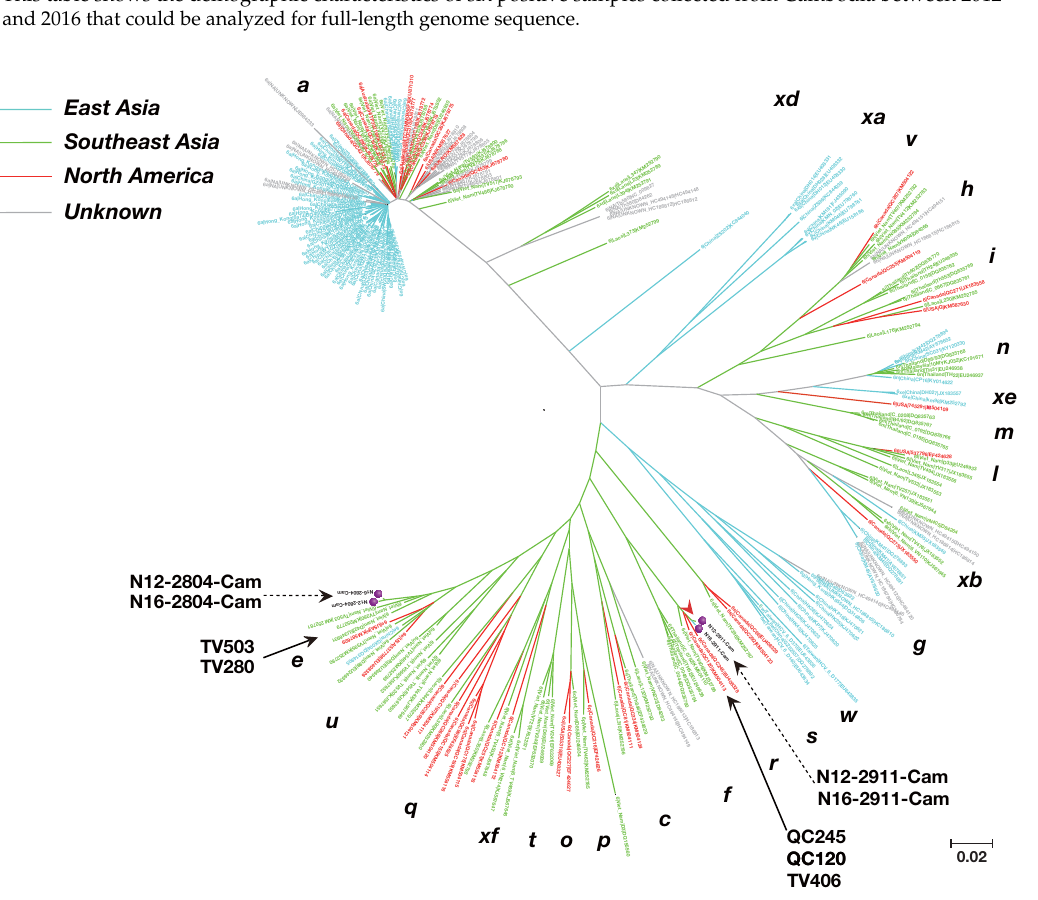
Figure 3. Phylogenetic tree constructed based on HCV genotype 6 near full-genome